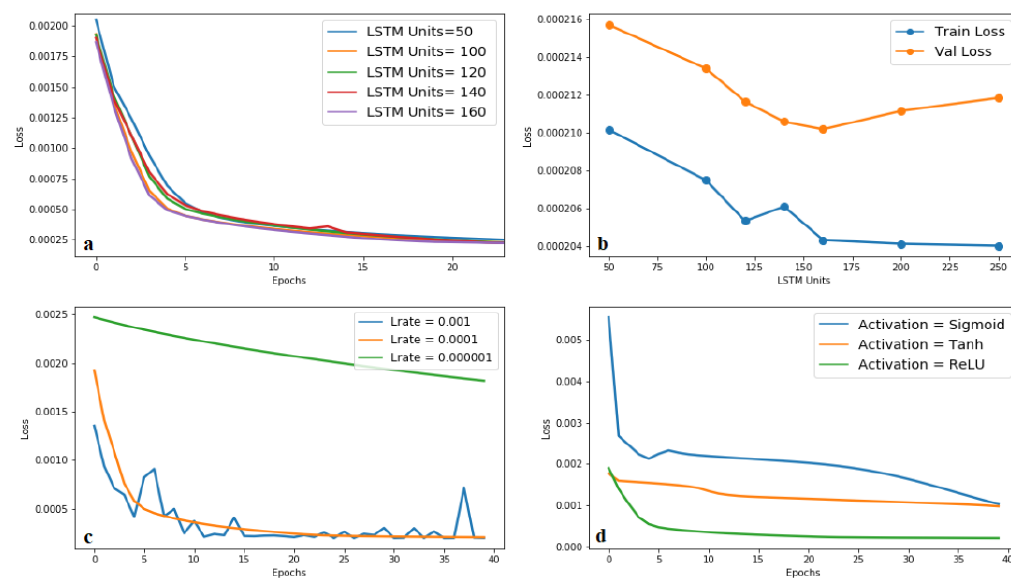
Figure 6. Effects of different hyperparameters on the learning behavior of the MFS-LSTM. ( a ) the learning behavior with varying layer widths corresponding to the first layer. ( b ) the influence of the layer width on the training and validation loss. ( c ) the influence of the learning rate on the training loss. ( d ) the impact of the activation function on learning behavior.